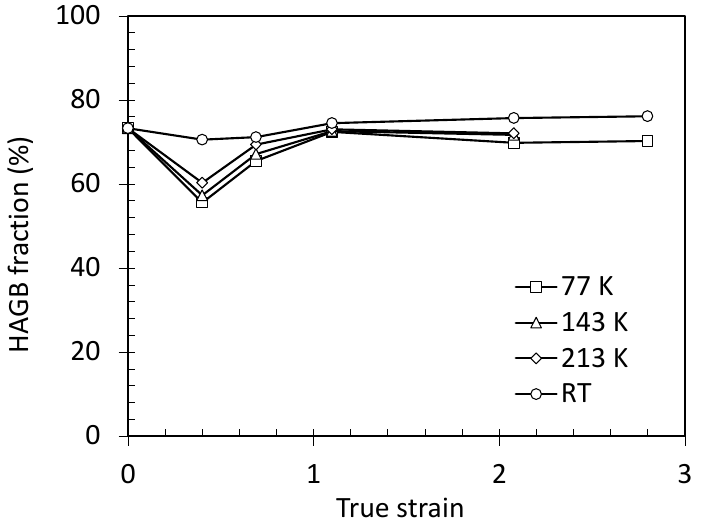
Figure 6. Evolution of high angle grain boundary area fraction as a function of strain and temperature during PSC.